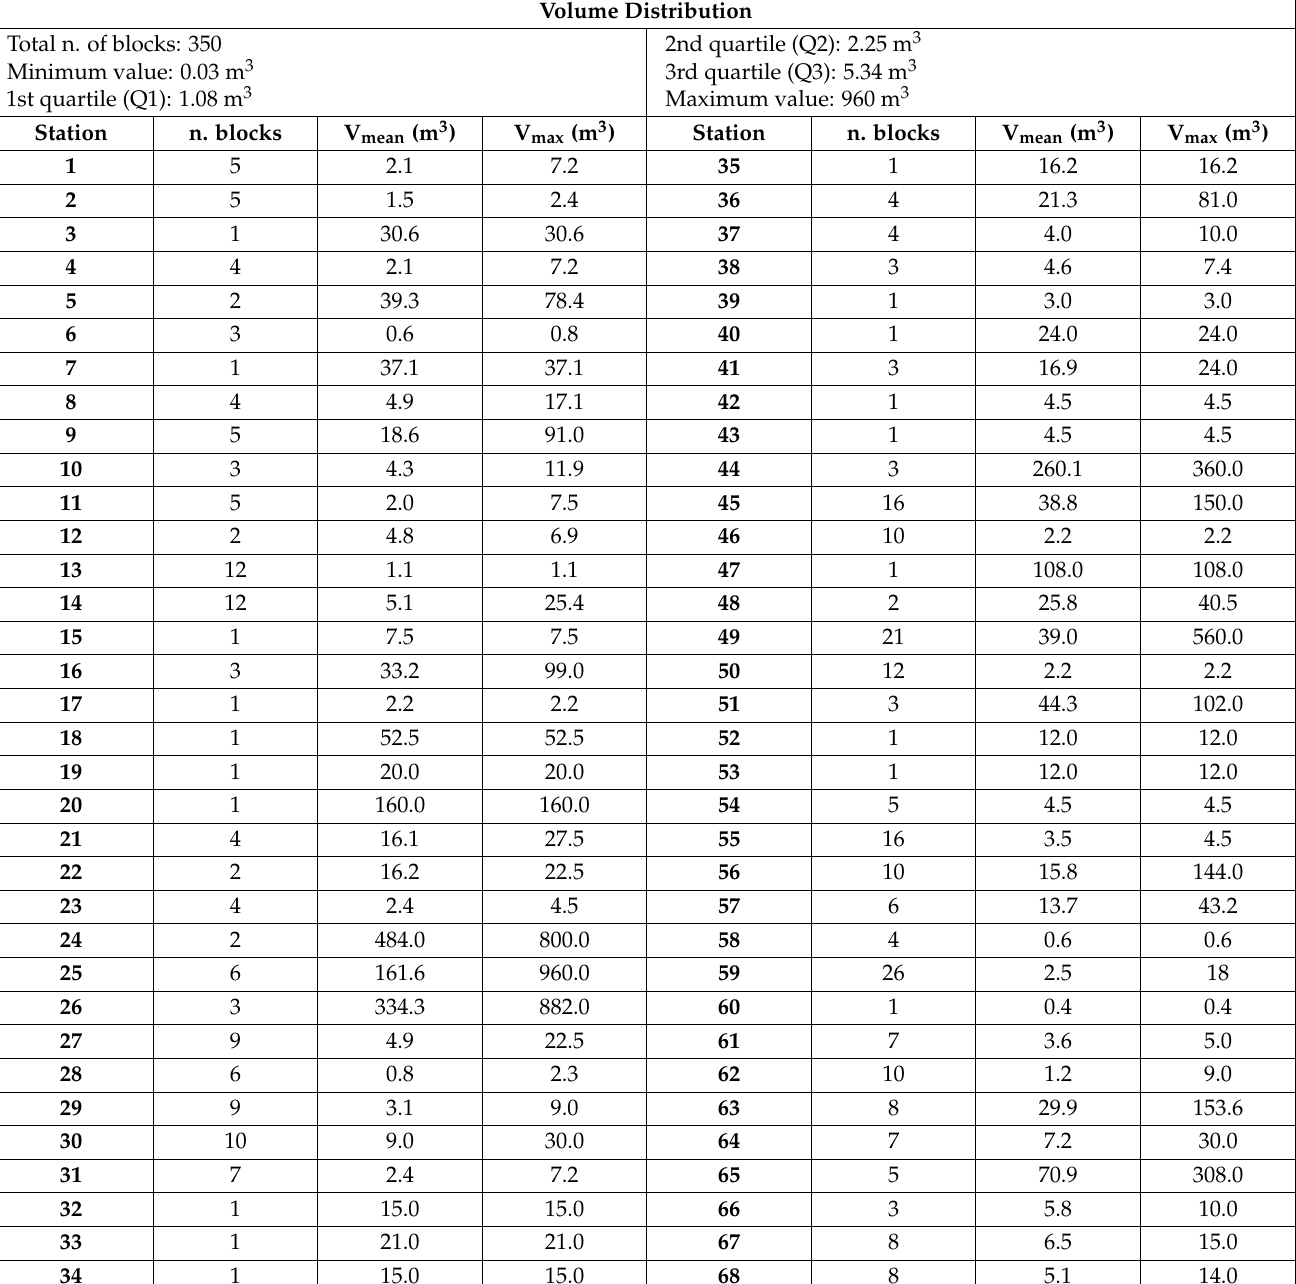
Table 1. Number, mean volume (V mean ) and maximum volume (V max ) of the blocks identified in each station during the field survey. In the upper part is the synthesis of the block’s volume